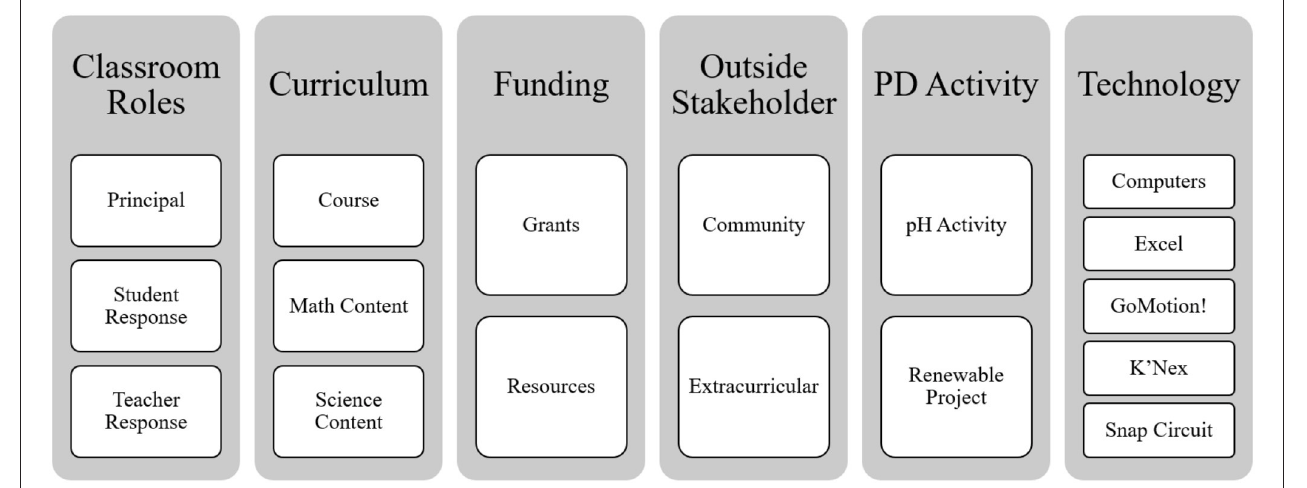
FIGURE 1 | Overview of axial and selective codes in the qualitative